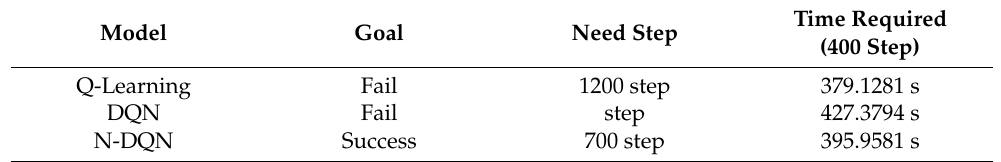
Figure 14. Visualization of the ping-pong game through reinforcement learning. 5.2. Training Features State is defined in the game as the current position coordinates of the actor’s paddle and the current position of the ball. The actor’s paddles and balls change their positions in real time according to actions, so it is implemented to acquire information again every time an action is performed. Action is defined as a direct movement of the actor’s paddle. The actor takes one of the four actions up/down/left/right. Because the player wins the round if the opponent’s paddle fails to receive the ball, a high-weighted reward is given. On the other hand, because the player loses the round if the actor’s paddle misses the ball, reward is given negatively. Table 6 shows the objects of leaning in the maze game.